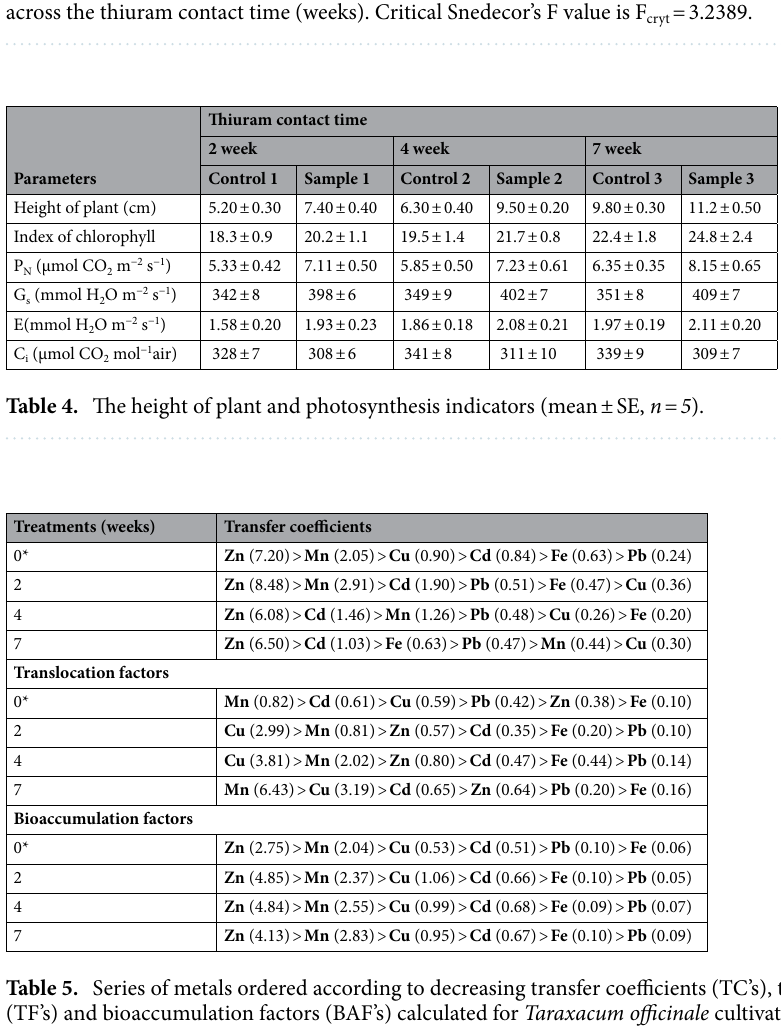
Table 3. One-way ANOVA for manganese, iron, copper, zinc, cadmium and lead contents in dandelion plant across the thiuram contact time (weeks). Critical Snedecor’s F value is F cryt = 3.2389.